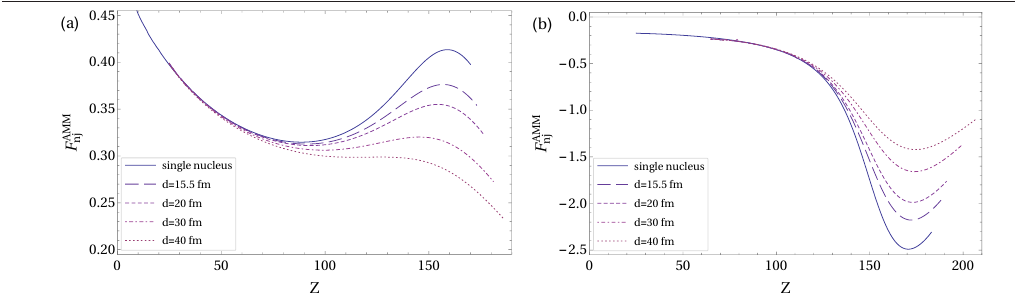
Figure 2. The function F AMM for the contribution from ∆ U AMM as a function of total charge Z for the nj lowest even (a) and odd (b) electronic levels in an H-like atom (solid) and in a symmetrical two-nuclei quasi-molecule for the fixed internuclear distances